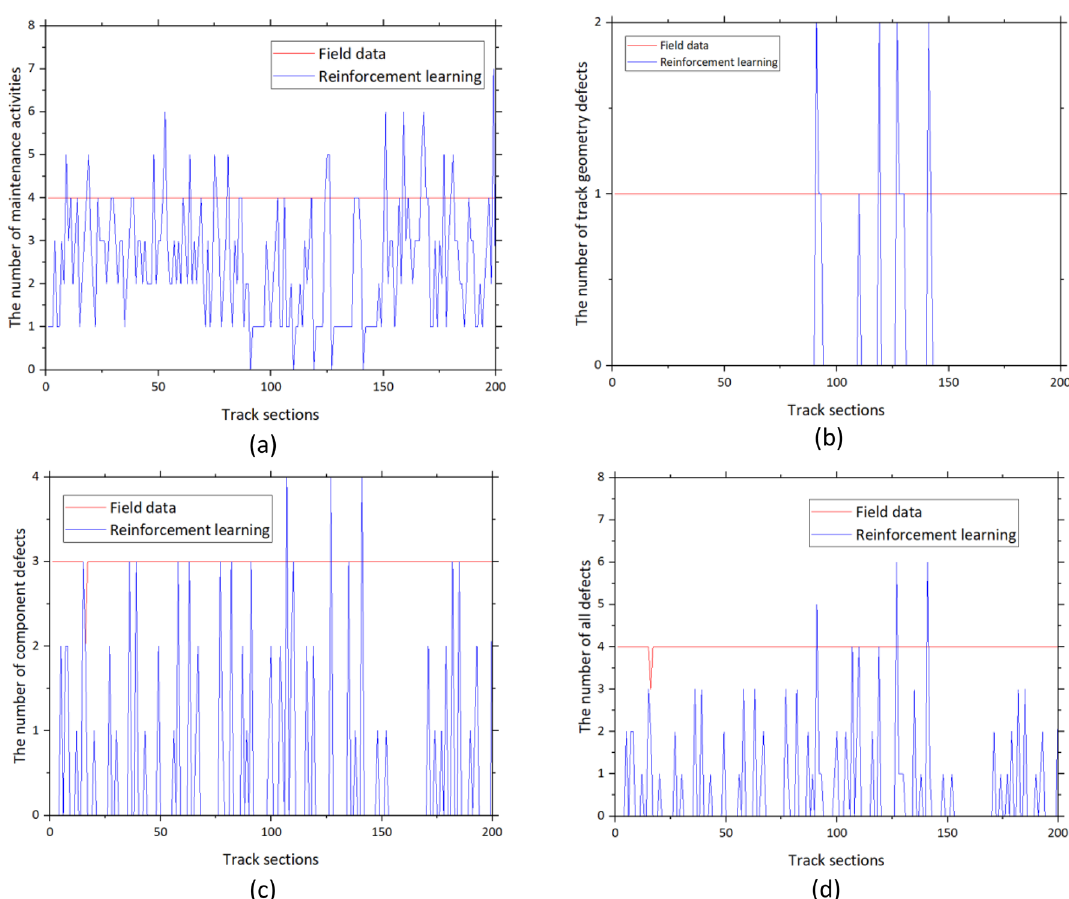
Figure 11. Examples of the maintenance efficiency improvement based on track sections ( a ) maintenance activities, ( b ) track geometry defects, ( c ) track component defects, and ( d ) all